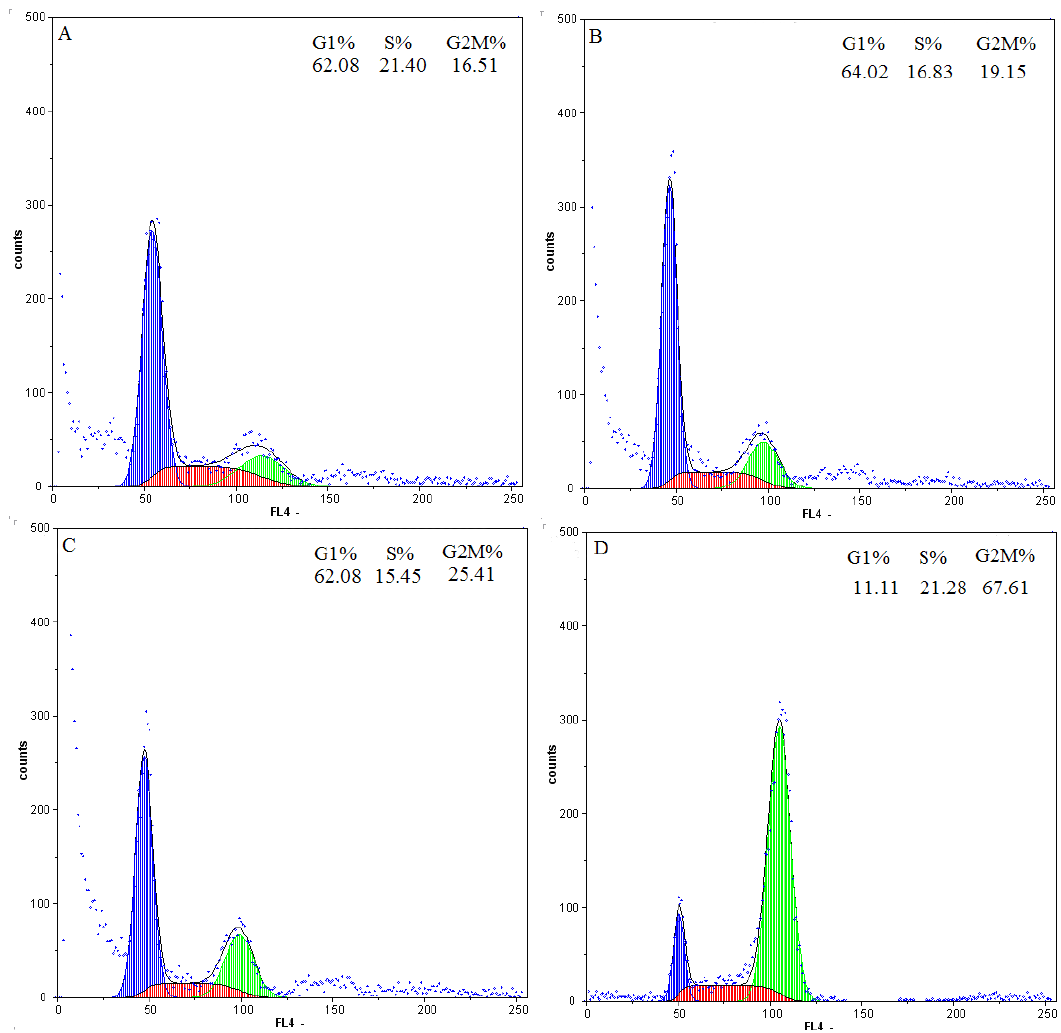
Figure 5. Flow cytometric analysis of daphnoretin-treated HOS cells for 48 h. A, HOS cells were treated with 0 μ M daphnoretin. B, Cells were treated with 1 μ M daphnoretin.